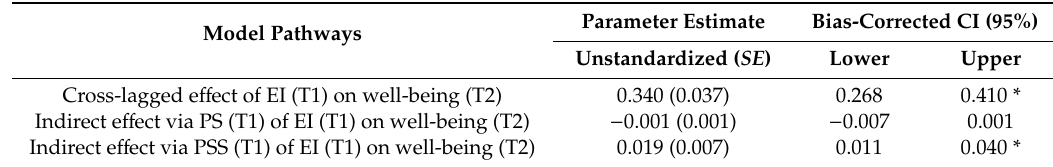
Table 2. Bootstrap estimates of the cross-lagged (time-specific direct) and mediational (time-specific indirect) e ff